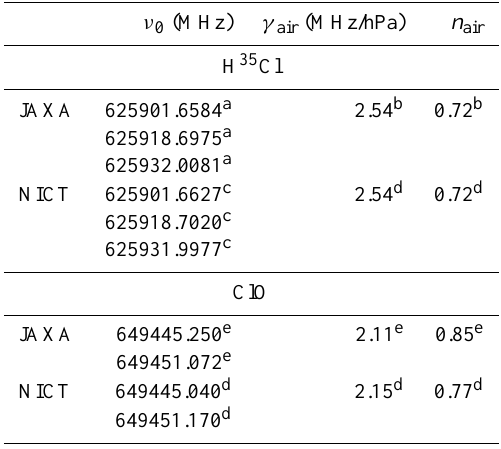
Table 1. Spectroscopic parameters for HCl and ClO in the SMILES forward models (see Sect.